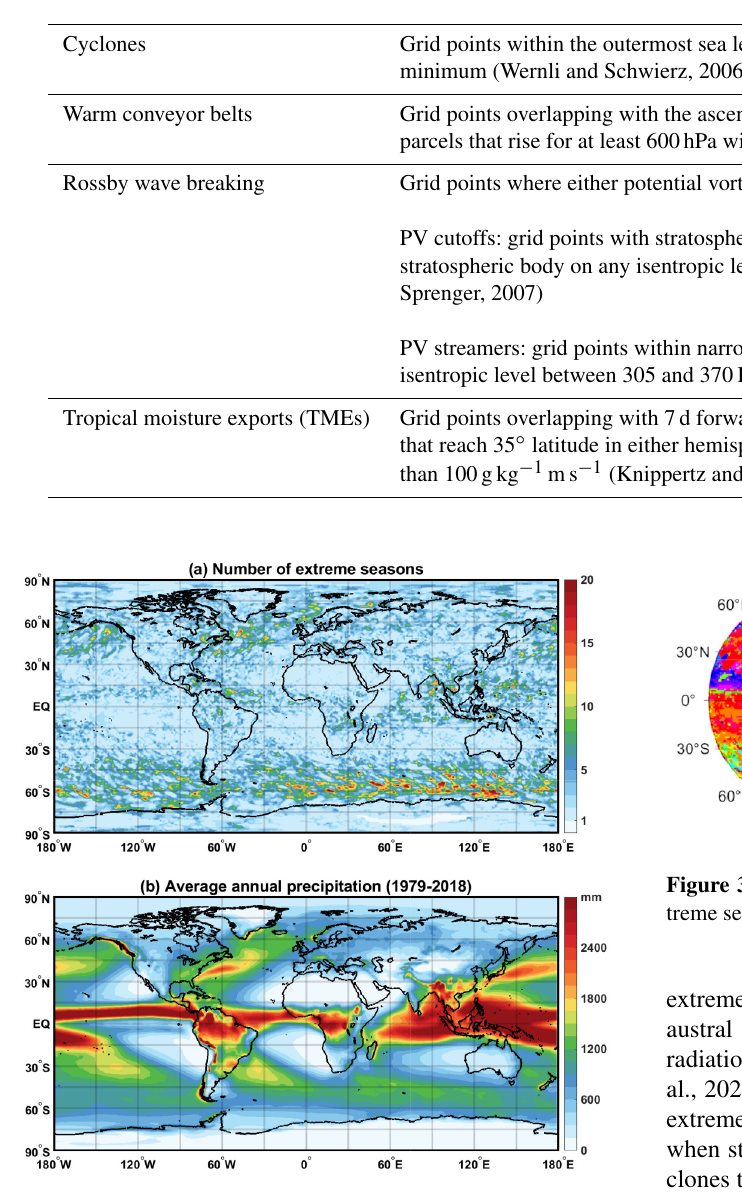
Figure 2. (a) Global distribution of the number of extreme seasons. (b) Average annual precipitation in a 40-year period (1979–2018).